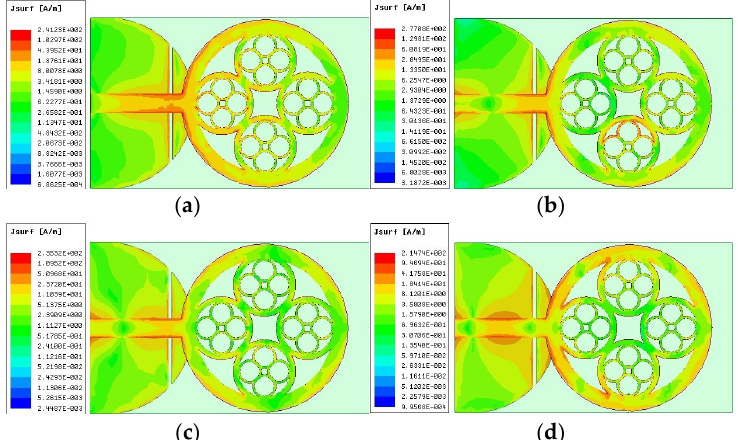
Figure 7. Suggested patch surface current distributions ( a ) at 3.17 GHz, ( b ) at 5.82 GHz, ( c ) at 7.86 GHz, and ( d ) at 9.16 GHz.